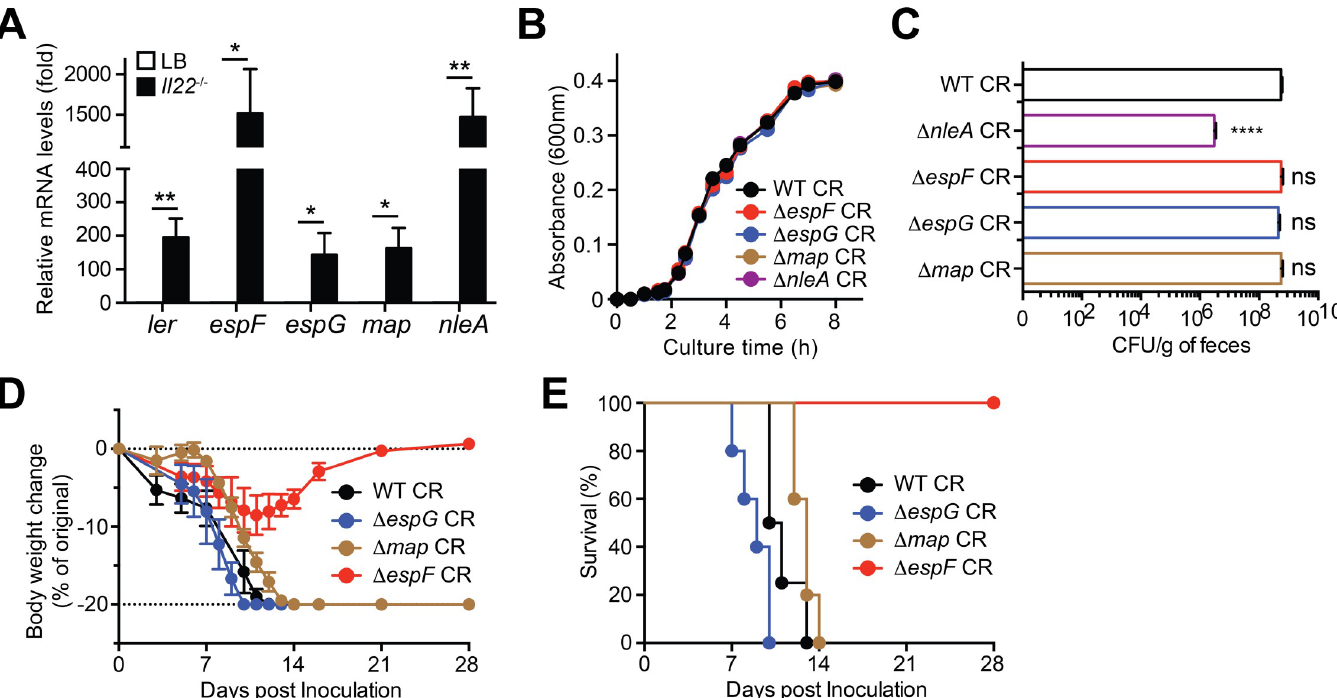
Fig 4. EspF plays a specific role for CR infection-caused lethality in Il22 -/- mice. A. Quantitative PCR was used to determine mRNA levels of ler , espF , espG , map , and nleA relative to 16S rRNA in the CR collected from LB culture or Il22 -/- mice at 7 days post inoculation (dpi) with wild-type Citrobacter rodentium (CR). Shown are mean ± SEM from 5 inoculated Il22 -/- mice, with mRNA levels in CR derived from LB culture set a 1. B. Growth curves of indicated CR strains in LB medium, at 1:150 dilutions from the overnight cultures. C. The colony formation units (CFU) of live CR derived from fecal samples of Il22 -/- mice, inoculated with 2 × 10 9 CFU of indicated CR strains, at 7 dpi. D-E. Weight loss (D) and survival rate (E) of Il22 -/- mice inoculated with WT (n = 4), Δ espG (n = 5), Δ map (n = 5), or Δ espF (n = 5) CR. ns, not significant, � p < 0.05, �� p < 0.01, and ���� p < 0.001 by Student’s t tests (A) and with one-way analysis of variance, followed by Bonferroni’s multiple comparison tests (C).